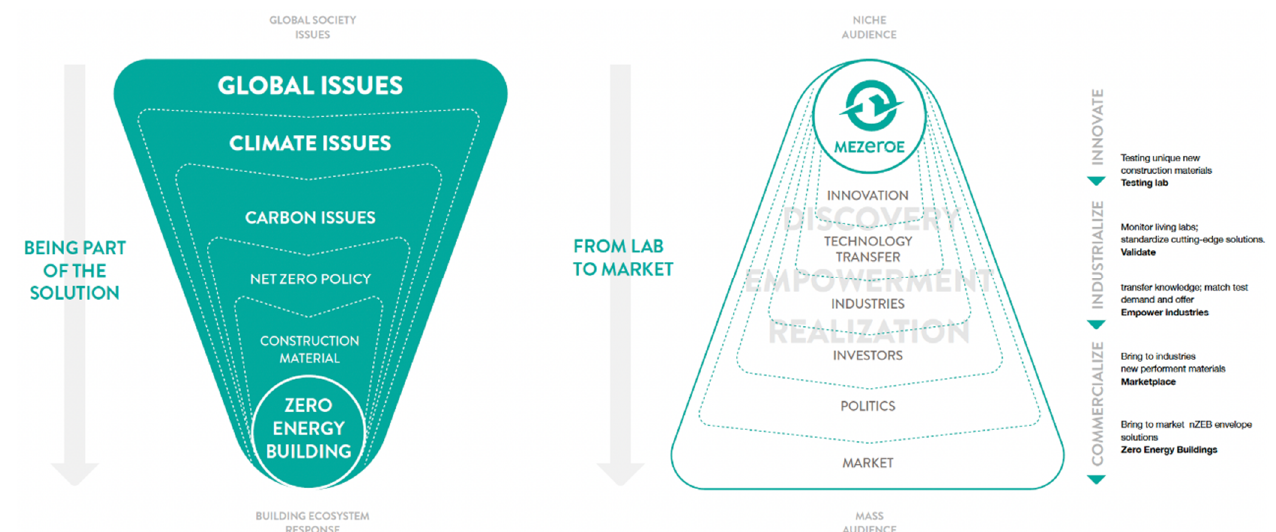
Figure 2. Diagram of the MEZeroE platform (schema by COMPAZ).